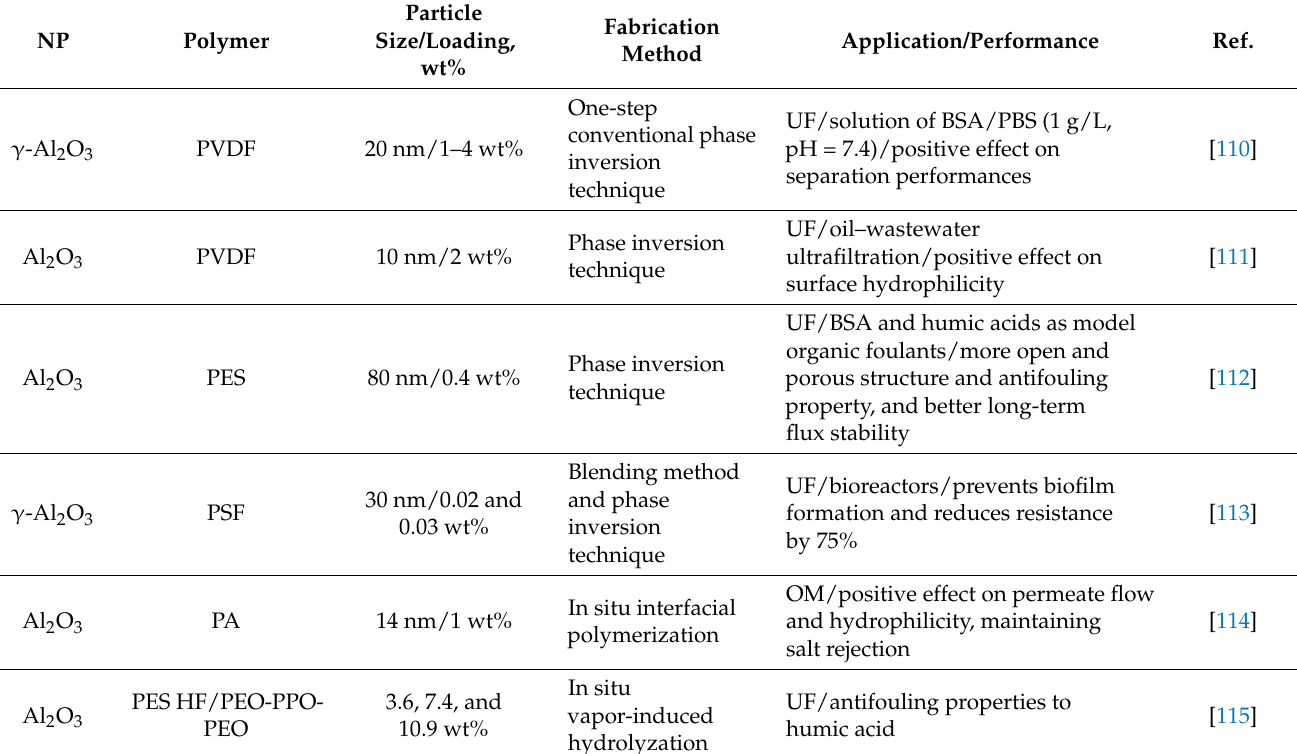
Table 4. Select applications of various types of aluminum in